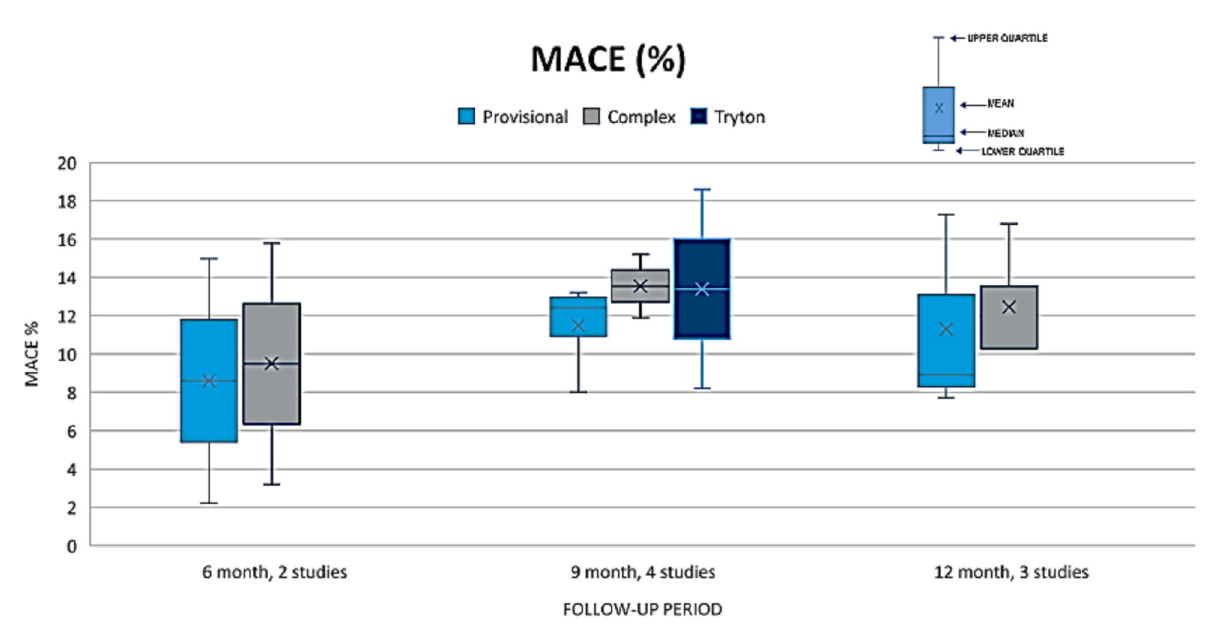
Figure 3. Studies reporting MACE (%) at 6, 9 and 12 months. MACE: major adverse cardiac